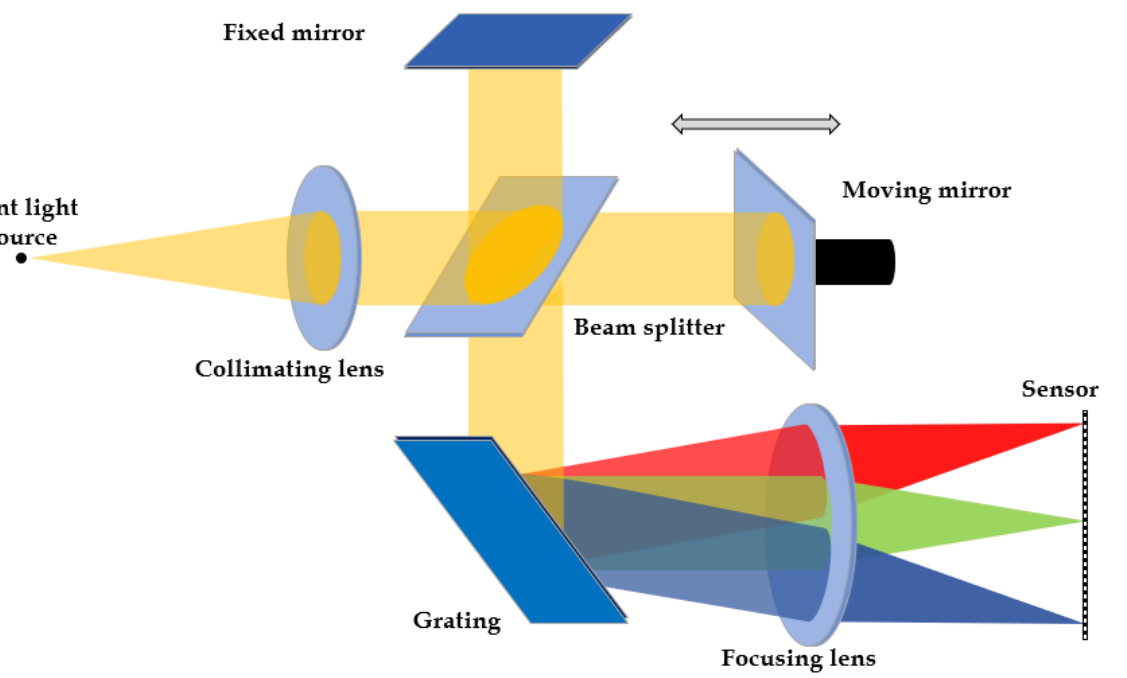
Figure 1. Basic schematic of Fourier transform spectroscopy with bandpass sampling (BPS-FTS).